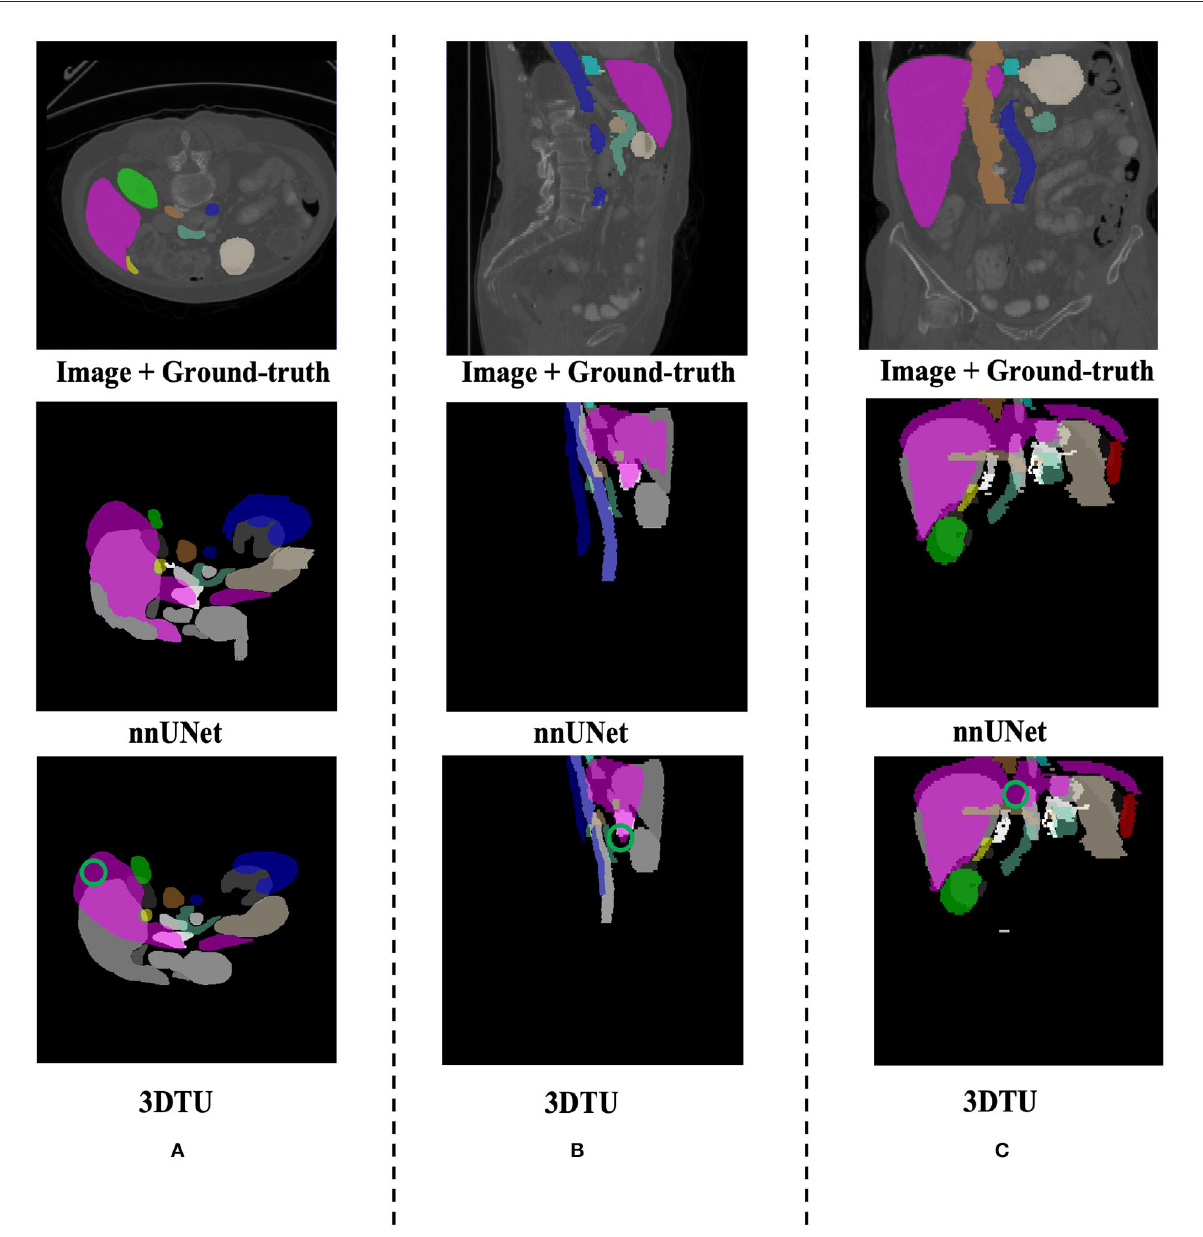
FIGURE5 Visualization of the segmentation results on the Synapse dataset produced by our 3DTU and nnUNet. Columns (A–C) show the x – y plane, y – z plane, and x – z plane of 3D segmentation predictions, respectively. The green circle indicates part of false-negative regions. Better view with colors and zooming